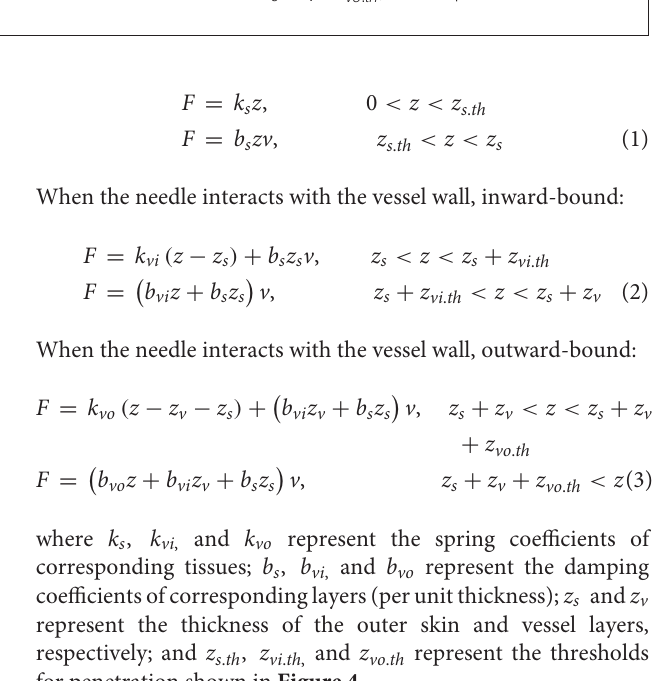
FIGURE 4 | Virtual needle penetration task. The dashed lines in the figure indicate the invisible vessel walls and the invisible part of the needle. The solid lines indicate the visible skin and the visible part of the needle. (A) Before contact. (B) Needle penetrates the skin when z > z s . th . (C) Needle penetrates the vessel inward when z > z s + z vi . th . (D) After successful penetration of vessel. (E) Needle penetrates the vessel outward when z > z s + z v + z vo . th ; outward penetration indicates task